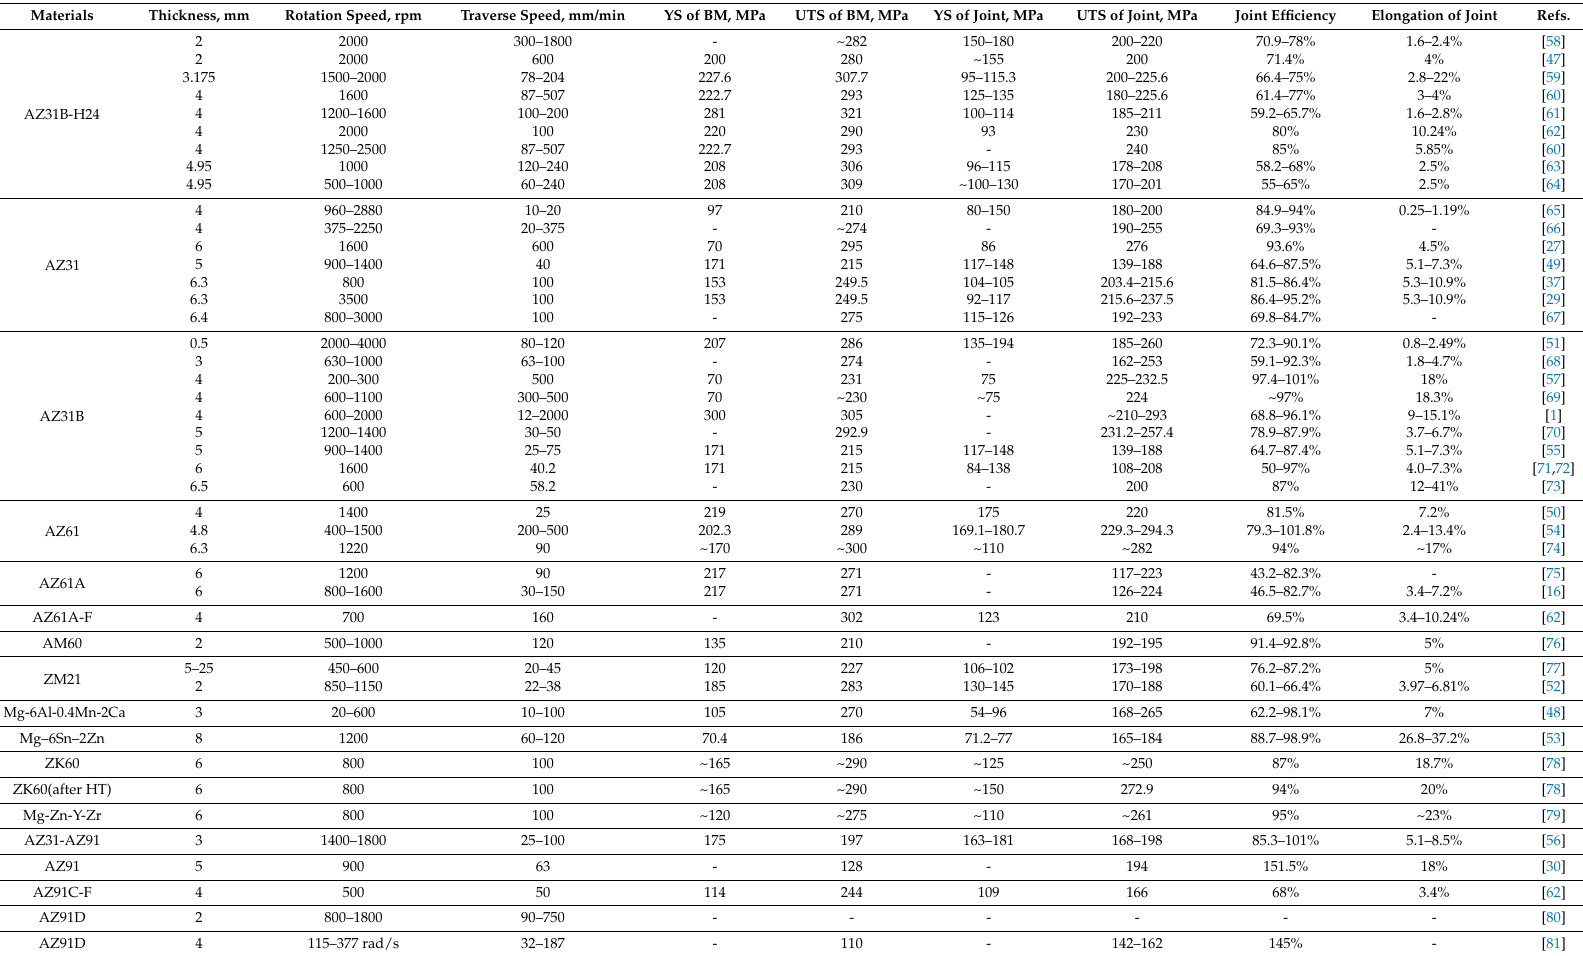
“-” indicates the data are not provided in the